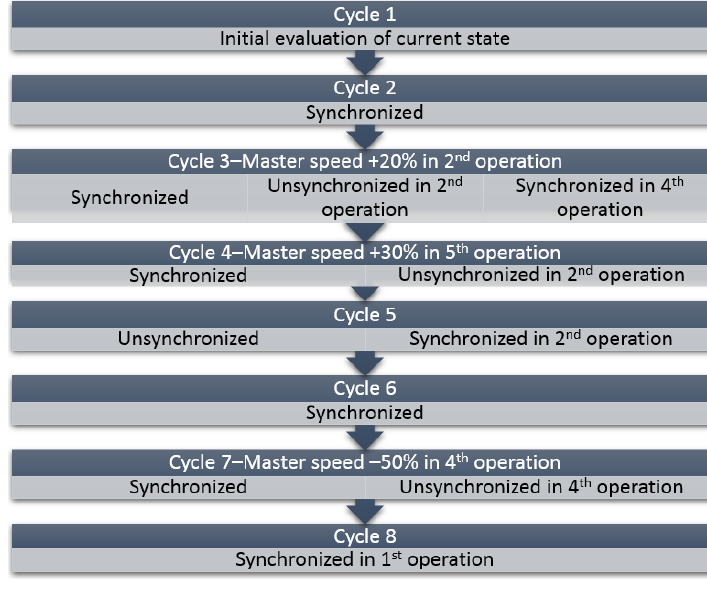
Figure 12. Brief summary of Experiment 1b results.